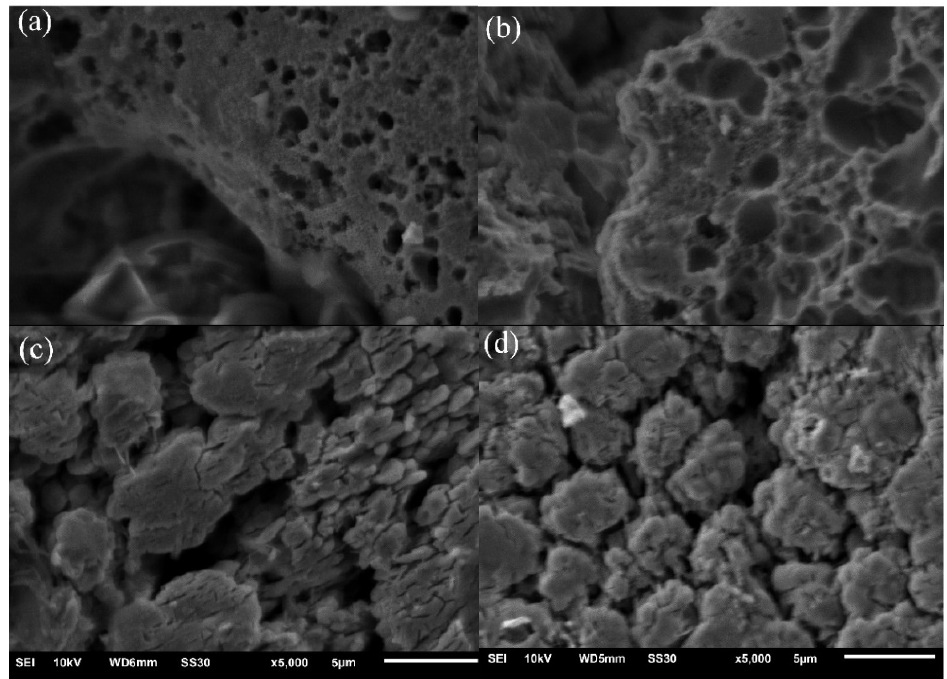
Figure 6. SEM images of batch 3 after leaching in 5 mol/L NaOH at different temperatures for different times. ( a ) 40 °C for 6 h. ( b ) 40 °C for 12 h. ( c ) 40 °C for 18 h. ( d ) 80 °C for 12 h. Table 3. Element mass percentages of batch 3 determined by XRF analysis.